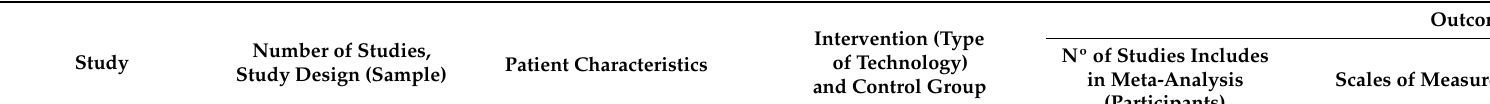
Table 1. Characteristics of the reviews included in the umbrella